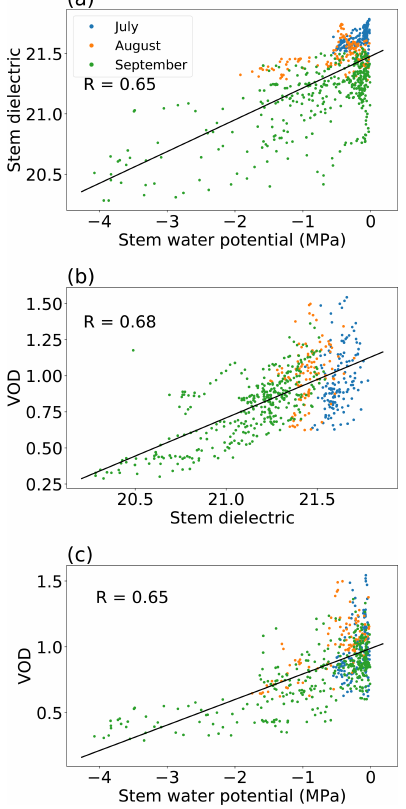
Figure 7. Scatter plots of stem xylem water potential, the stem xylem apparent dielectric permittivity at 70MHz, and VOD with linear fits. Stem measurements are from a single tree. The 3 months labeled by color correspond to three successive installations of the stem psychrometer used to measure stem water potential. For each scatter plot, Pearson correlations ( R ) are shown for the whole period as well. See Table S1 in the Supplement for Pearson correlations and Spearman rank correlations for each